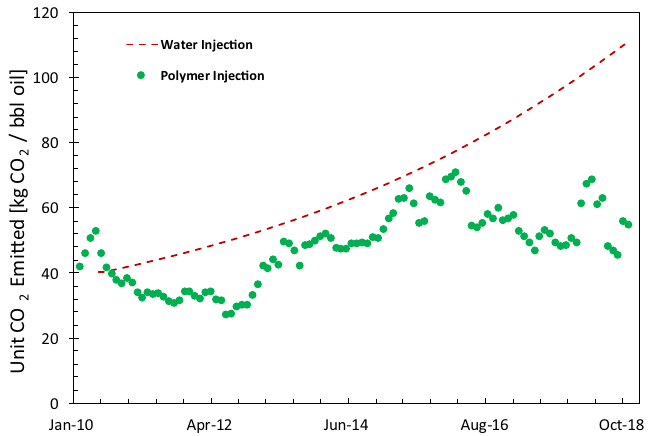
Figure 8. History of CO 2 emitted for field B in the Middle East from the start of the project in January 2010 until October 2018. The calculations are based on the data from one injection pattern in the field.